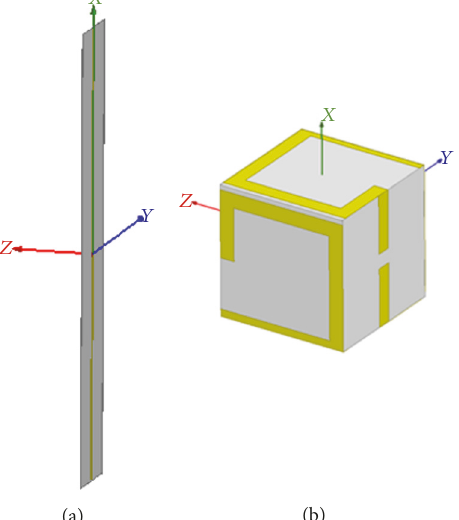
Figure 7: The Tx (0-0) orientation of the Tx antenna (Rx (0-0) of the RX antenna): (a) dipole antenna and (b) 3D cubic